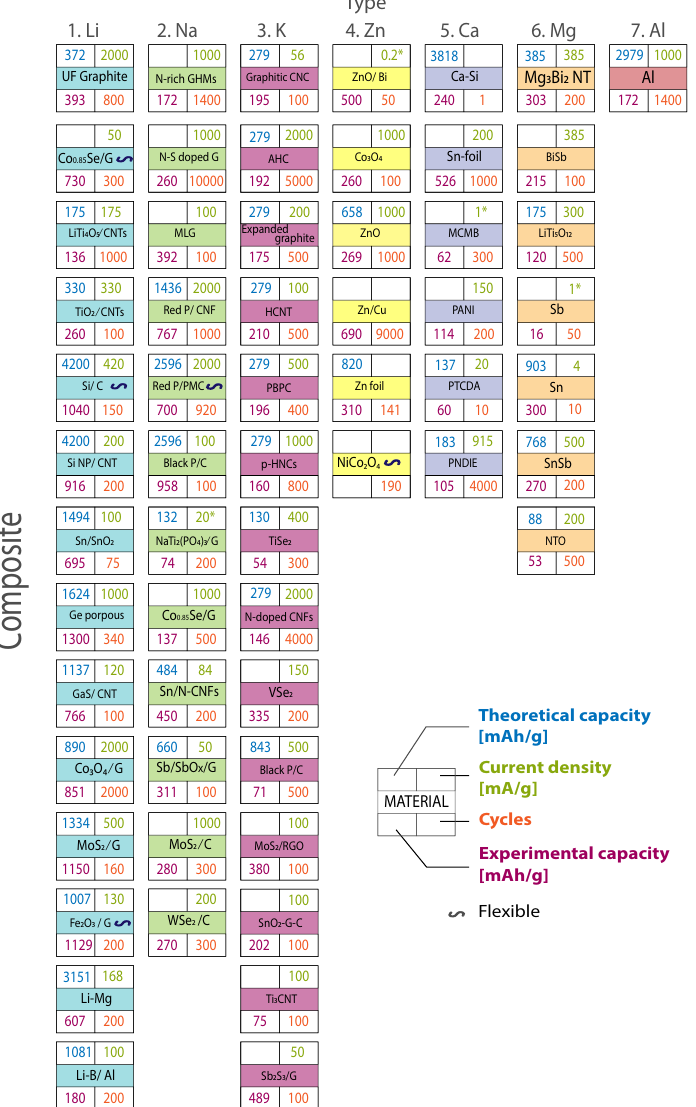
Figure 7. Current research in anode materials. Columns organize the seven battery types. Rows represent the composite material group. Theoretical capacity, experimental capacity, current density, and the number of cycles are also included. A special symbol highlights flexible anode materials. Graph constructed by the authors from references in Tables